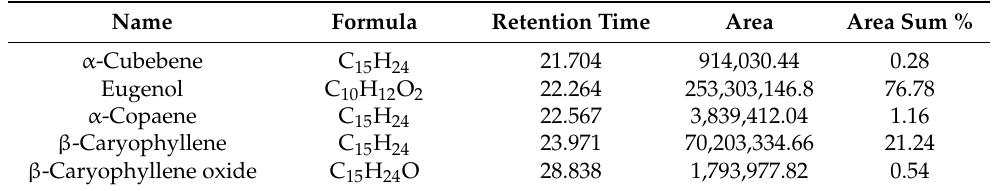
Table 1. Chemical composition of clove ( Syzygium aromaticum ) essential oil.